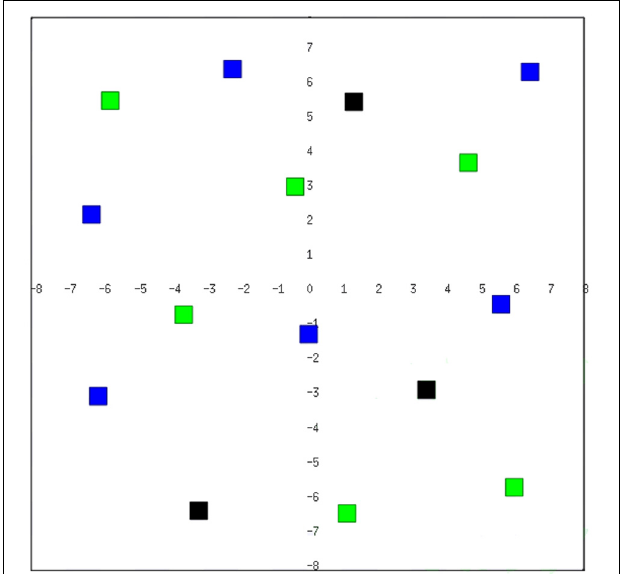
FIGURE 3 | The testing environment is simulated through the Player/Stage tool for robotics development (Gerkey et al., 2003). We adopt a simulated Pioneer3-DX mobile robot endowed with a blob camera and 16 sonar sensors. The black, blue, and green colored cubes (of